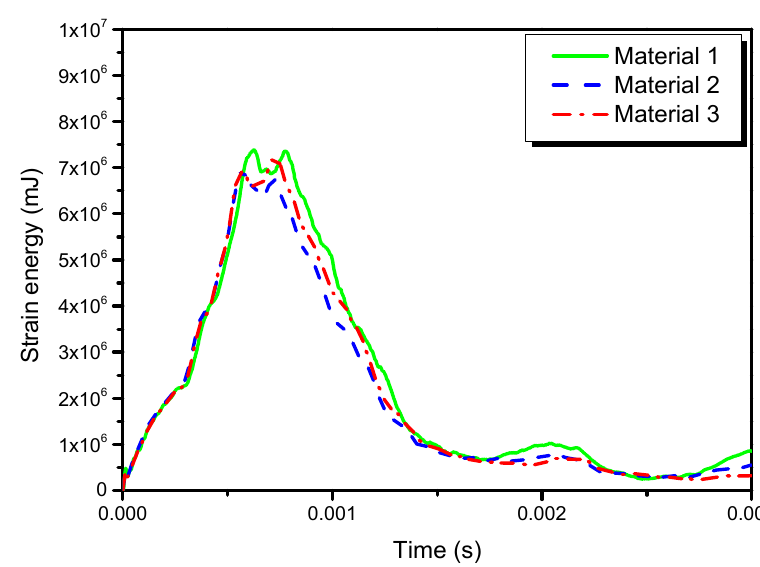
Figure 14. Time histories of the kinetic energy in the three models.